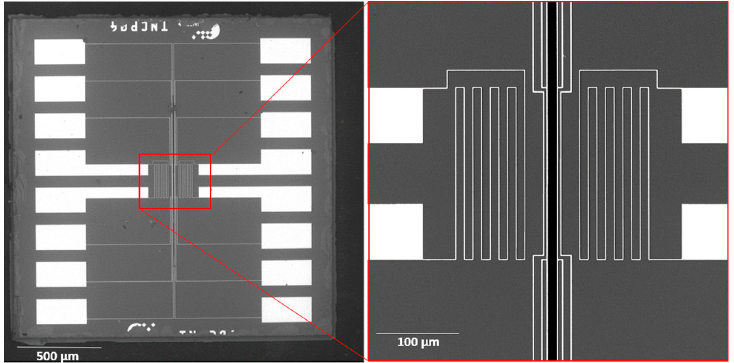
Figure 1. Micro photograph of the TNCP chip. A wide trench is etched from the chip backside to realize a membrane which is separated by a long and narrow gap for a thermal insulation of both chip